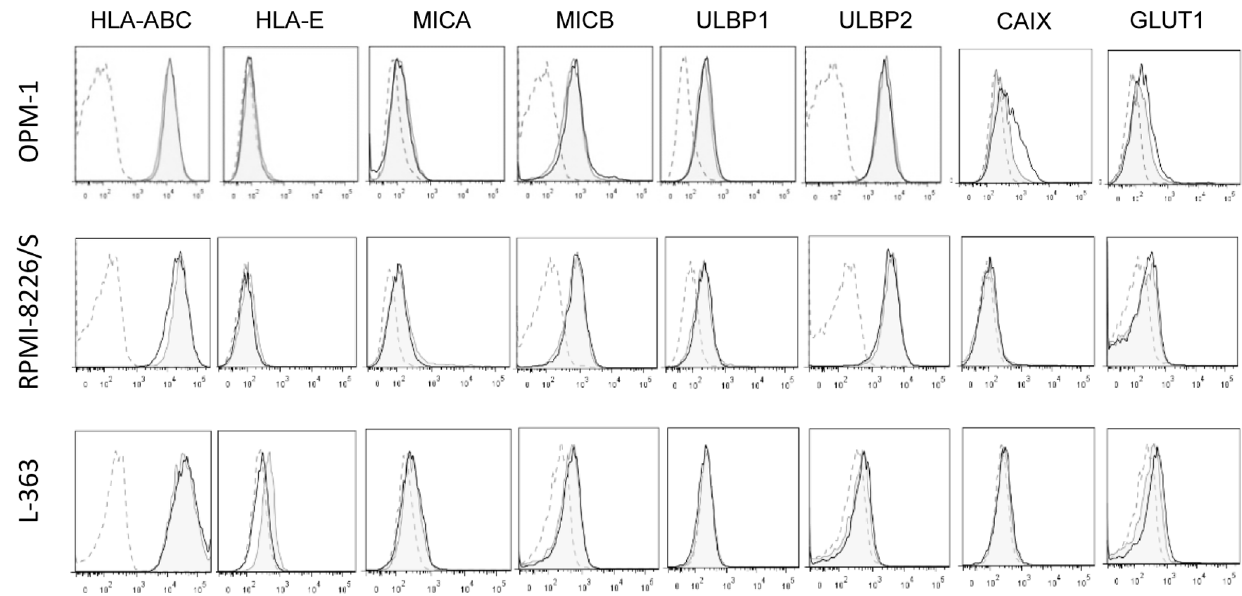
Figure 3. Hypoxia does not have an effect on surface expression of HLA-ABC and –E and NKG2D ligands. HLA-ABC, HLA-E and NKG2D ligands MICA/B and ULBP1-2 surface expression on OPM-1 target cells was analyzed after 14–16 hours of incubation at 21% O 2 (grey filled) or 0% O 2 (solid black line). Matched isotype control is depicted by a dashed line. Expression of hypoxia associated hypoxia makers CAIX and GLUT1 was analyzed by flowcytometry after 14–16 hours incubation at 21% O 2 (grey filled) or 0% O 2 (solid black line). Matched isotype control is depicted by a dashed line.